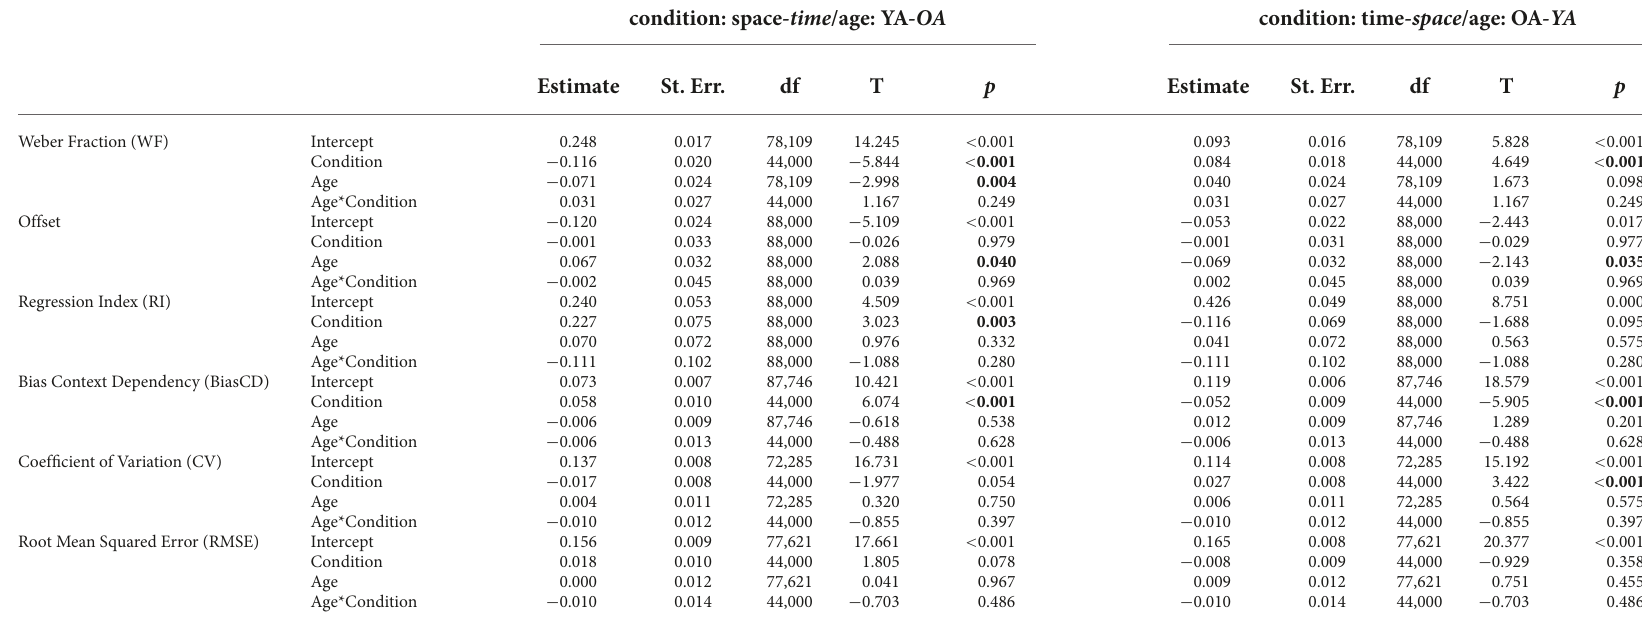
TABLE 2 Results of the linear Mixed Effect Models for the seven perceptual measures of the discrimination and the reproduction tasks. Results of the 7 Linear Mixed Effect